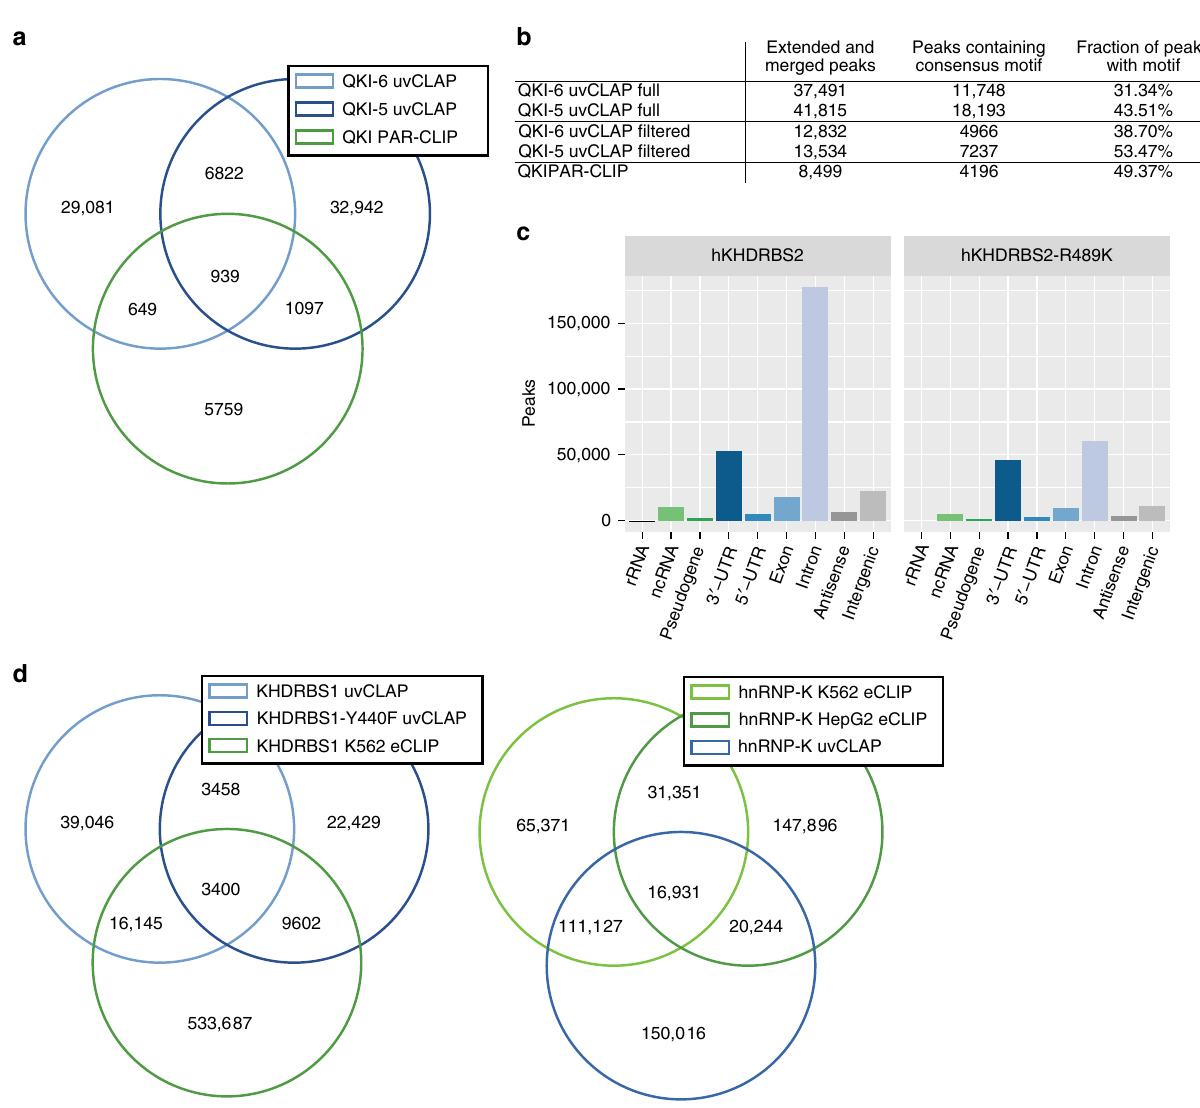
Fig. 5 Comparison of uvCLAP to other methods. a Overlap between the full sets of QKI-5 and QKI-6 uvCLAP and QKI PAR-CLIP peaks. Peaks were extended to a minimum length of 41 nt, adjacent or overlapping sites were merged. b QKI-5, QKI-6 and QKI PAR-CLIP sites containing the consensus motif AYUAAY. c Number of JAMM peaks located on genomic target classes. Each peak was assigned once to the category with highest priority corresponding to the order rRNA, ncRNA, pseudogene, 3 ’ -UTR, 5 ’ -UTR, exon, intron, antisense, intergenic. d (left) Overlap between the full sets of KHDRBS1, KHDRBS1 Y440F uvCLAP and KHDRBS1 K563 eCLIP peaks. (right) Overlap between the full sets of hnRNPK uvCLAP, hnRNPK K562 eCLIP and hnRNPK HepG2 eCLIP peaks. Peaks were extended to a minimum length of 41 nt, overlapping or abutting sites were